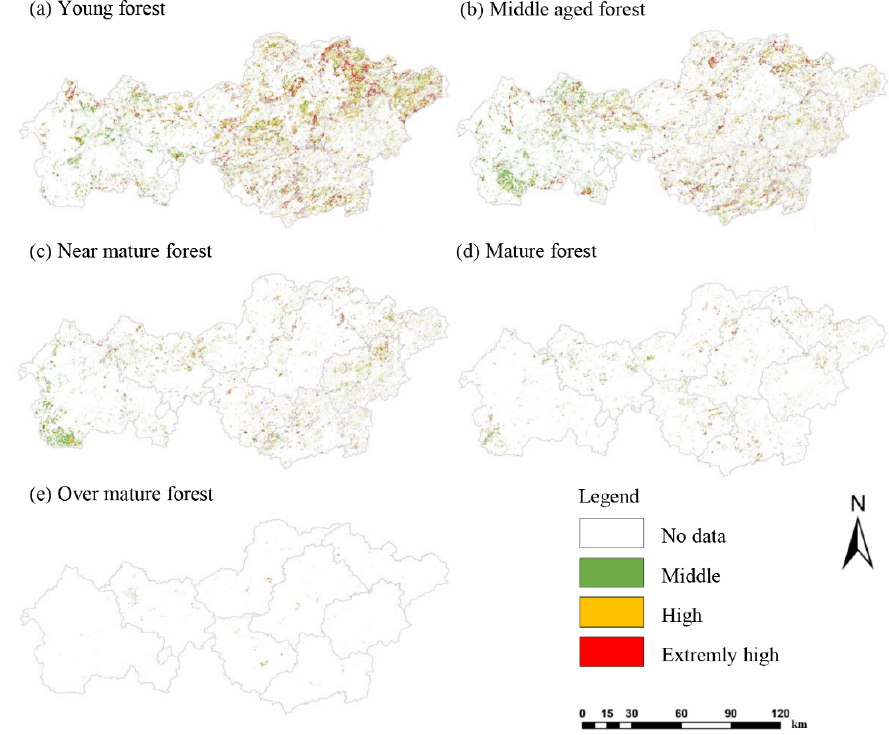
Figure 6. Spatial distribution map of forest age landslide susceptibility in Bijie